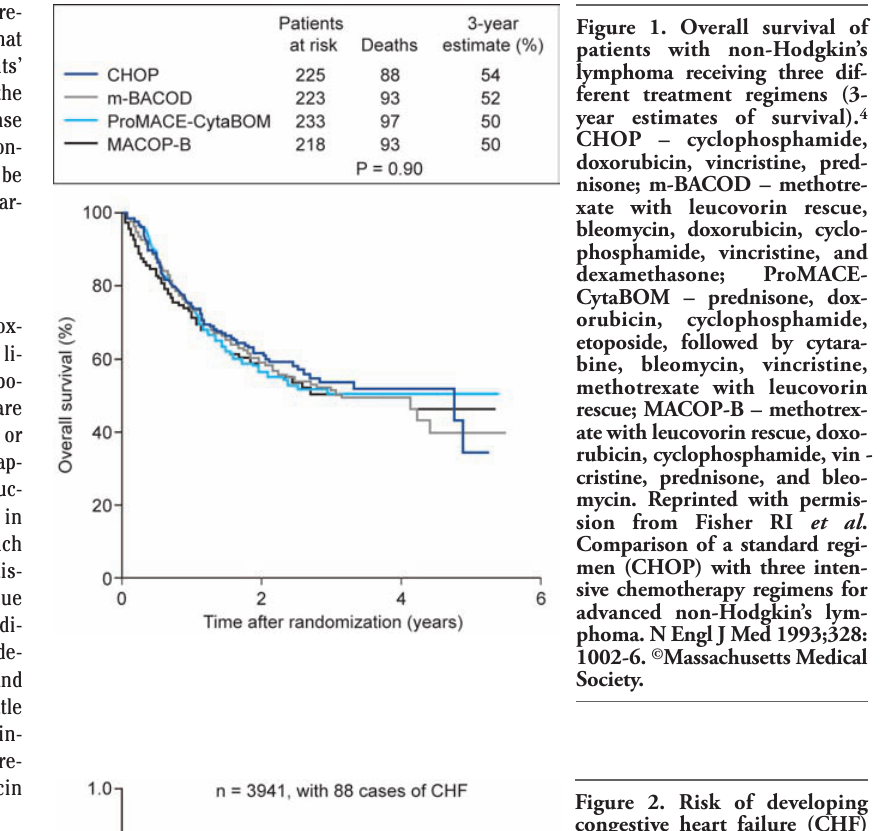
Figure 2. Risk of developing congestive heart failure (CHF) in relation to the cumulative dose of doxorubicin. 13 Reprint -